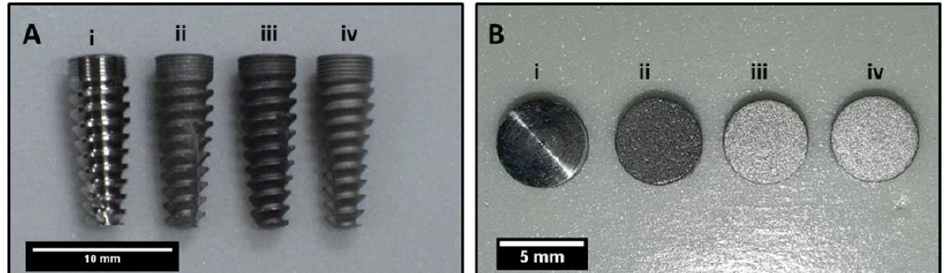
Figure 1. ( A ) Photograph of (i) machined, (ii) sandblasted, (iii) sandblasted and acid-etched at room temperature (R.T.), (iv) sandblasted and acid-etched at high temperature (HT) implants. ( B ) Disc samples in similar processing conditions.